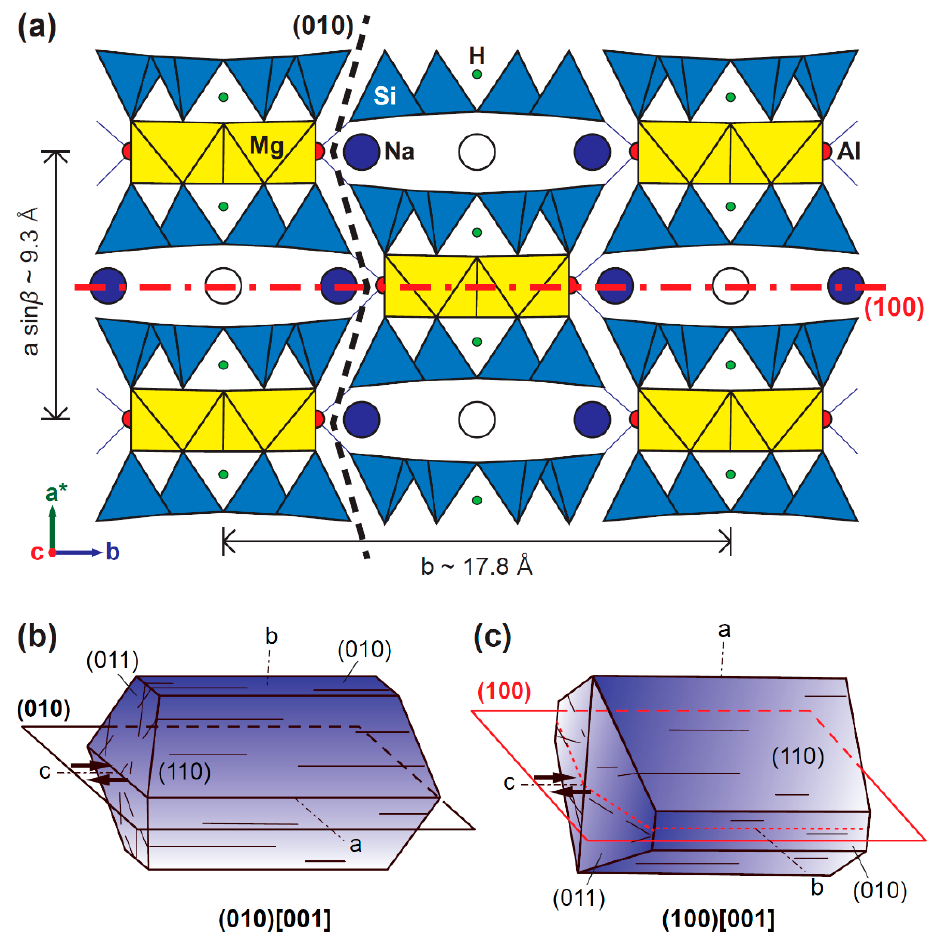
Figure 9. ( a ) Simplified glaucophane crystal structure projected onto the (001) plane. Black dashed and red dot-dashed lines indicate the tracks of the easiest slip system planes at low and high shear strain, respectively. Blue tetrahedron: Si-O structure, yellow octahedron: Mg-O structure ( M1 site), red circle: Al ( M2 site), green circle: H, blue circle: Na ( M4 site), and white circle: empty space ( A -site). The Mg-O octahedron in the M3 site has been omitted; ( b , c ) schematic of the glaucophane crystal form and di ff erent dominant slip systems in glaucophane. The transparent truncate sheet and black arrows indicate a dominant slip plane and a dominant slip direction,